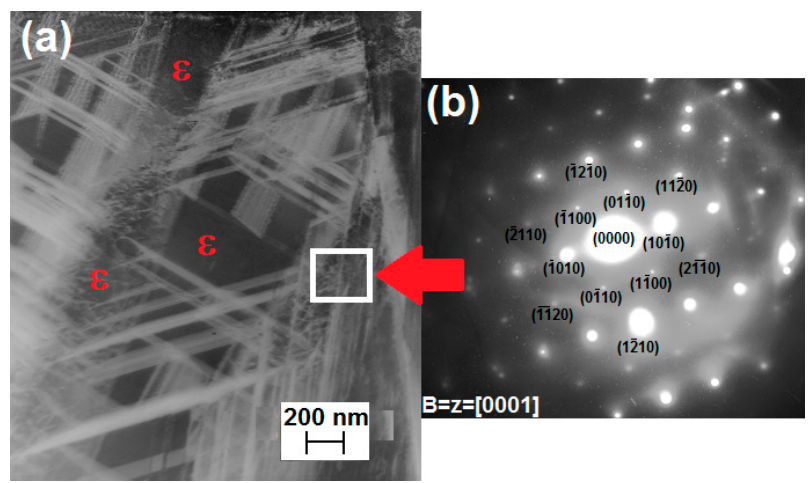
Figure 15. Heat ‐ treated Co ‐ 20 wt. %Cr: ( a ) TEM micrograph showing HCP ε‐ Co plates and ( b ) Figure 15. Heat-treated Co-20 wt. %Cr: ( a ) TEM micrograph showing HCP ε -Co plates and corresponding electron diffraction pattern. ( b ) corresponding electron diffraction pattern.